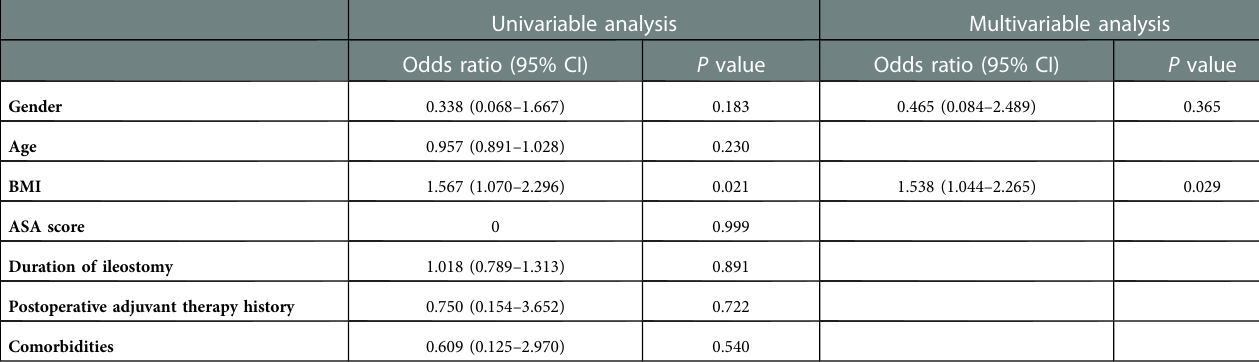
TABLE 3 Logistic regression analysis of potential factors related to perioperative